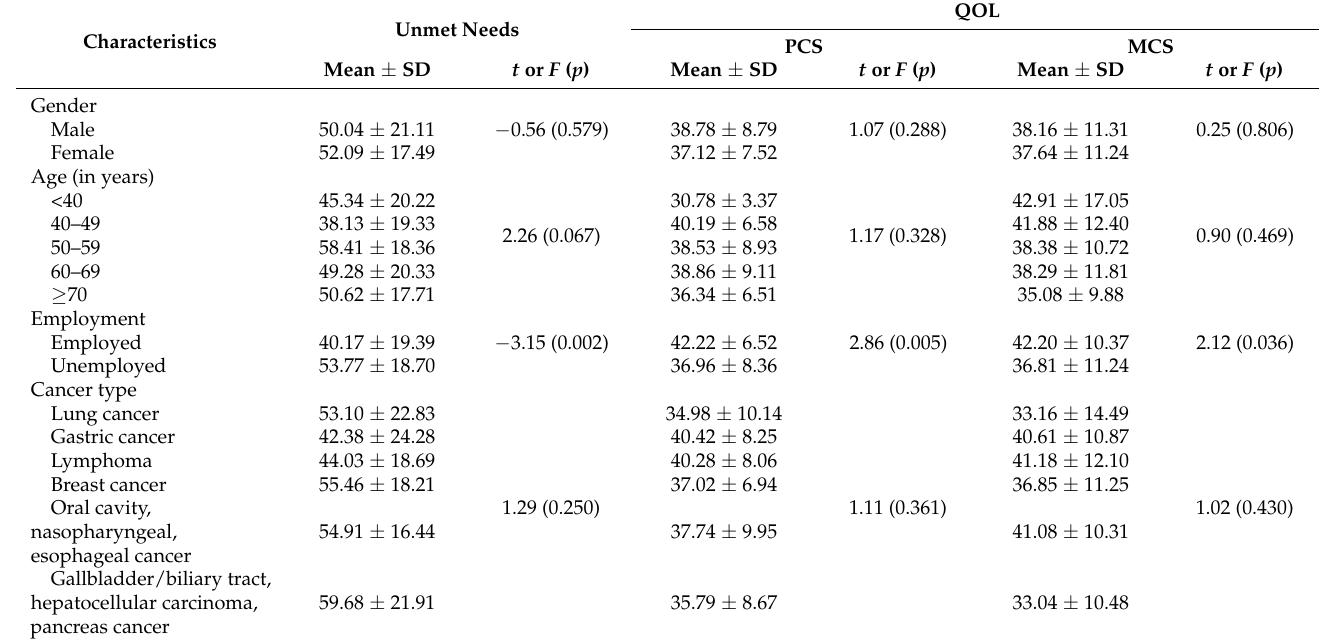
Table 3. Differences in measured variables on the general and disease-related characteristics (Patient).